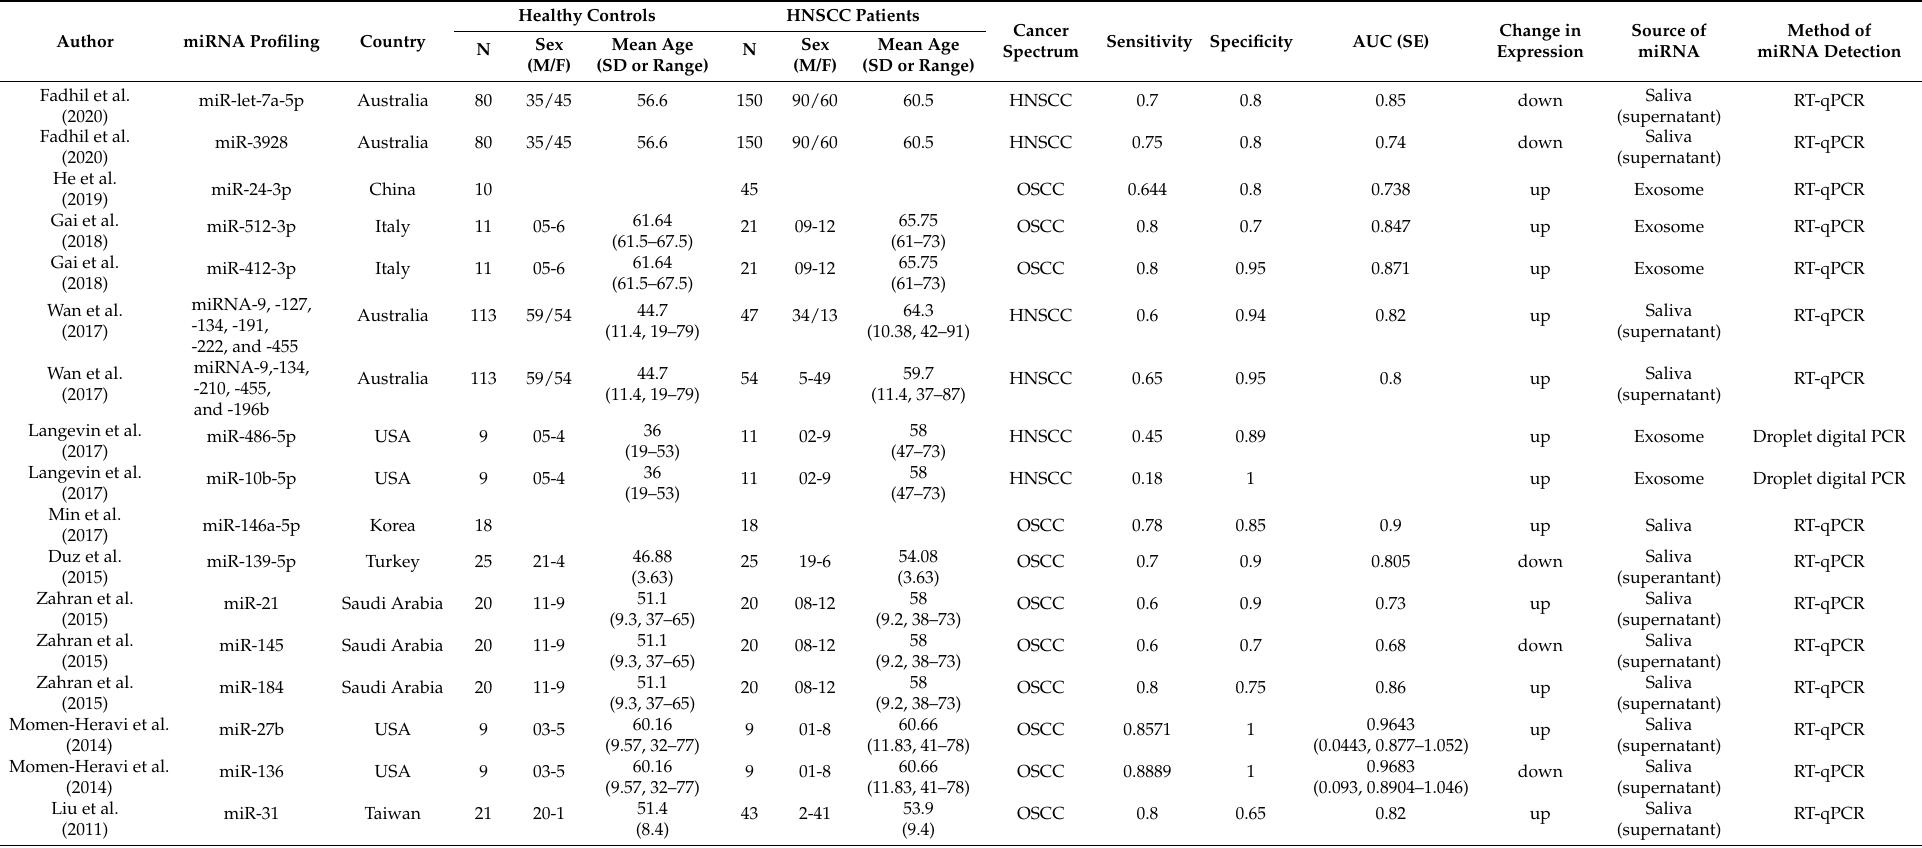
Table 1. Extracted data for performing the statistical